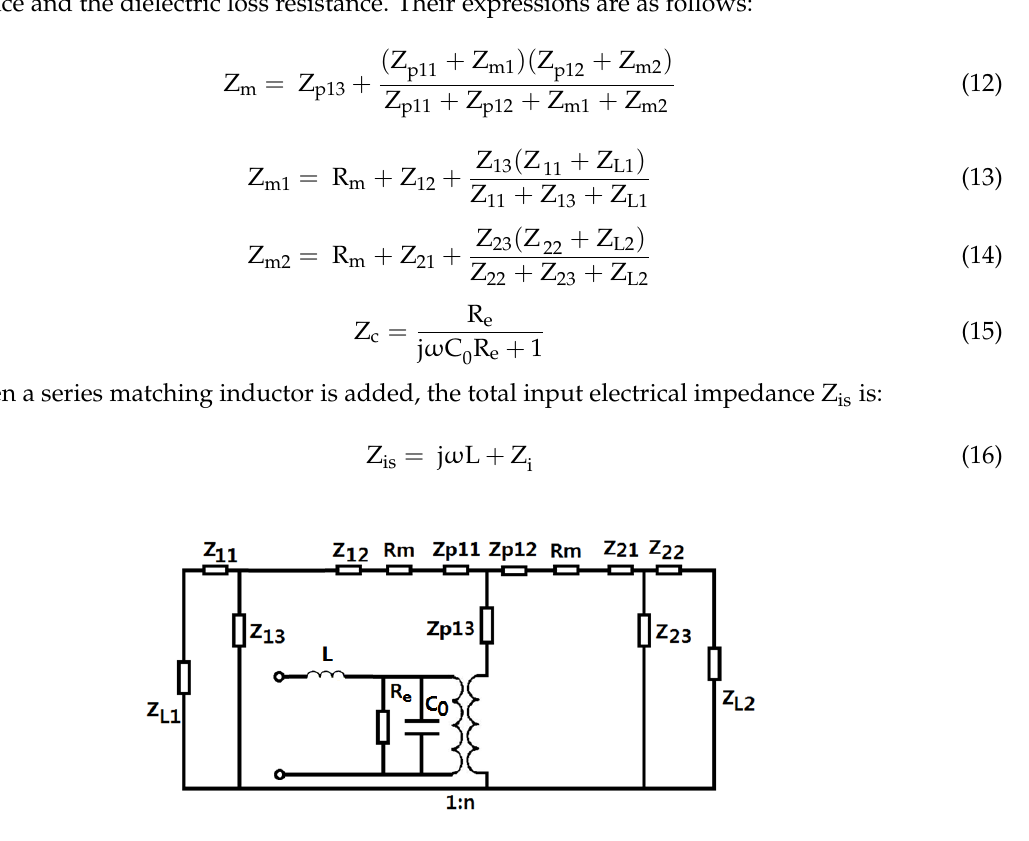
Figure 4. Electro-mechanical equivalent circuit of a sandwiched piezoelectric transducer with a series matching inductor.